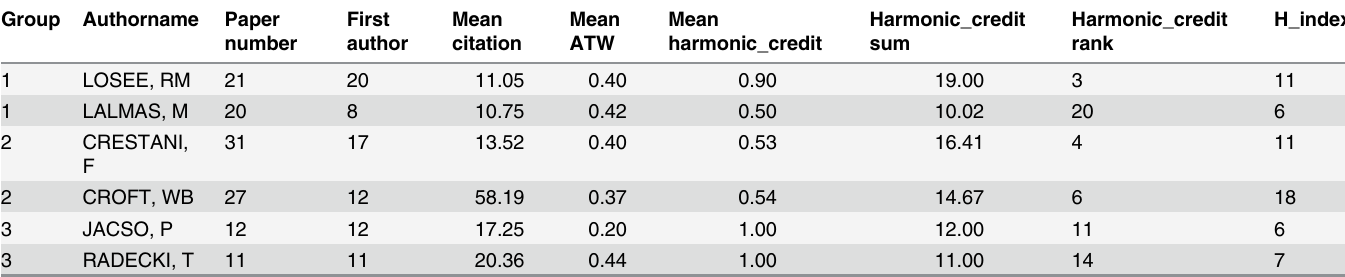
Table 1. Examples of evaluating the author transdisciplinary